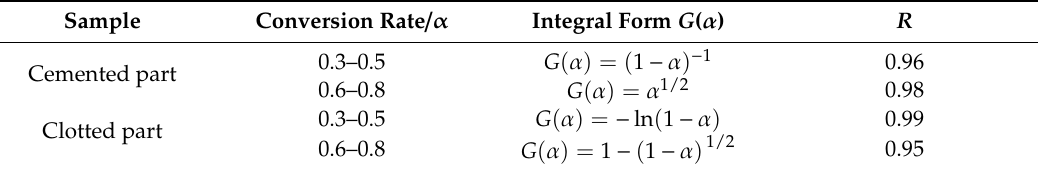
Table 1. The optimal mechanism functions of cemented and clotted